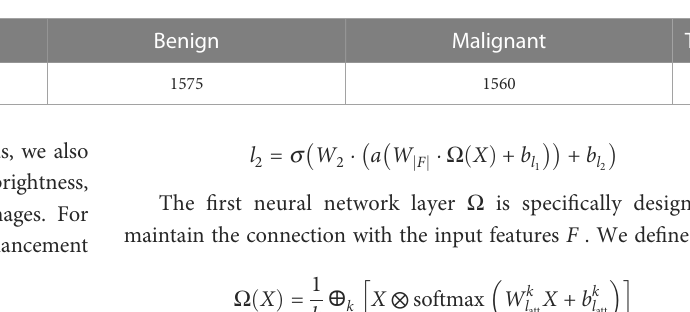
TABLE 4 The amounts of different types of data in MIAS dataset using data augmentation.